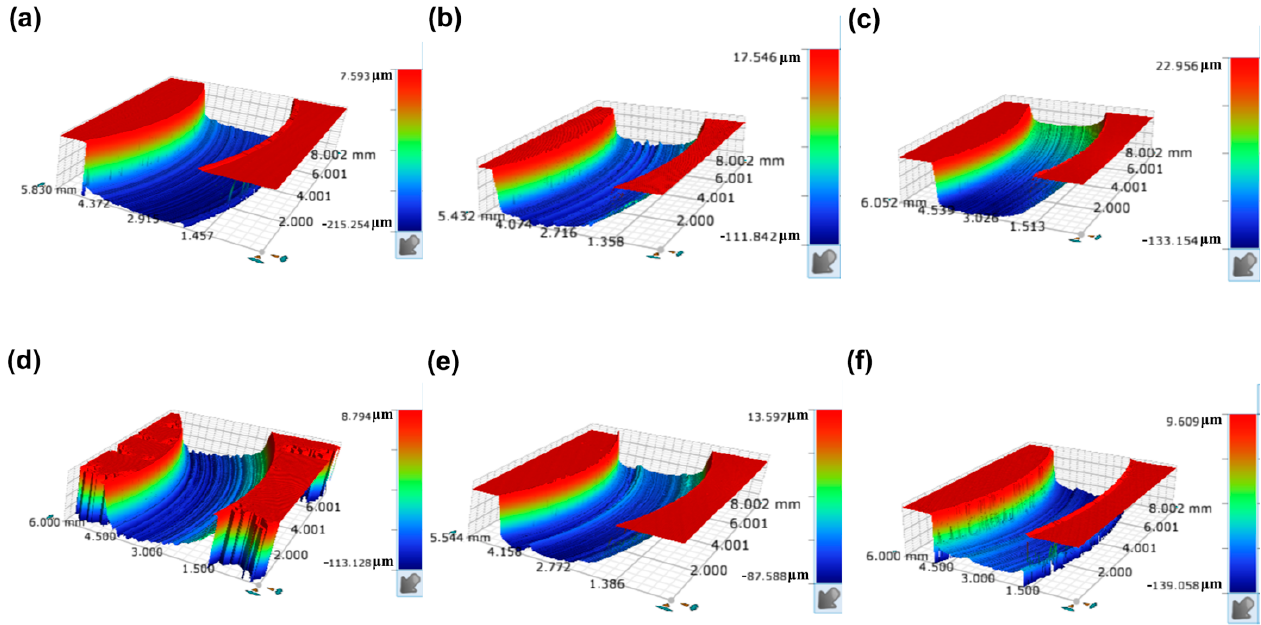
Figure 8. 3D optical interferometry images of the surface topography: ( a ) 0 M, ( b ) 5 M, ( c ) 10 M, ( d ) 15 M, ( e ) 20 M, ( f ) 25 M.The numbers in the Figure 8 represent the size of the observed part of specimens with different treatment processes. Table 2. The roughness of the worn surface and the depth in the furrow section of different specimens.